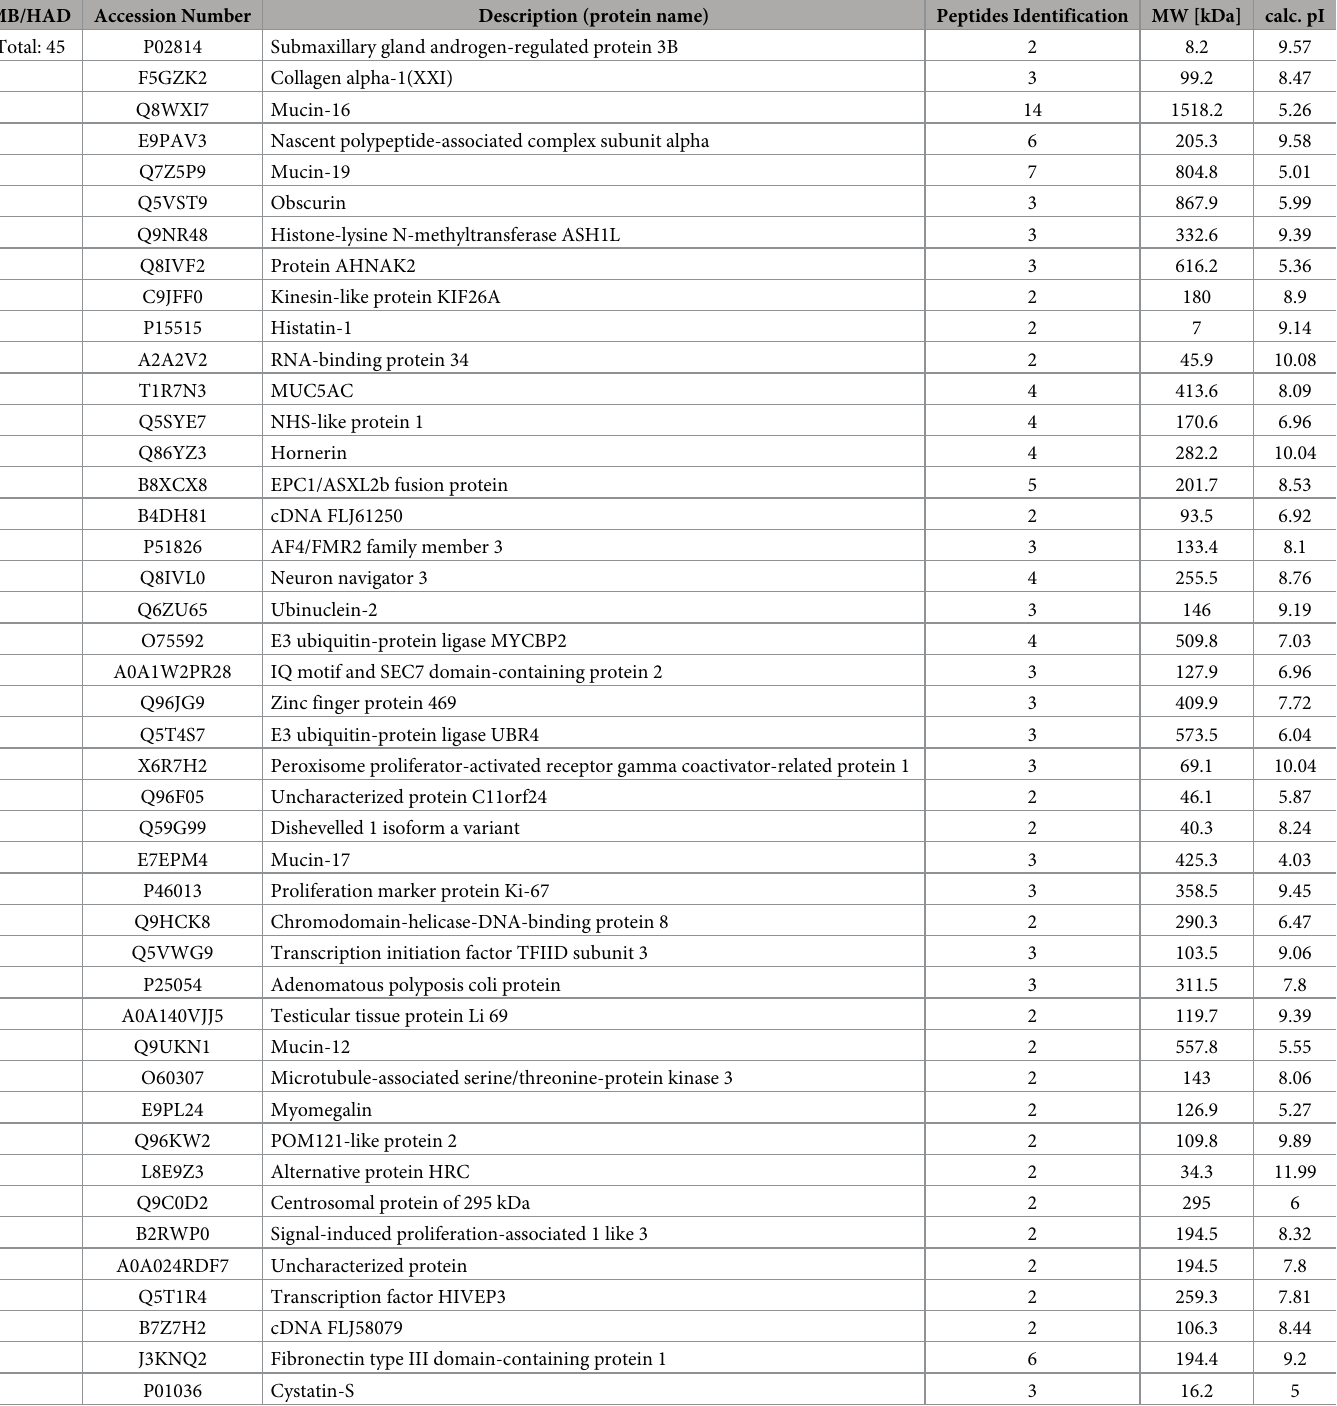
Table 2. Proteins identified in both groups, hydroxyapatite discs and metallic orthodontic bracket. MB/HAD Accession Number Description (protein